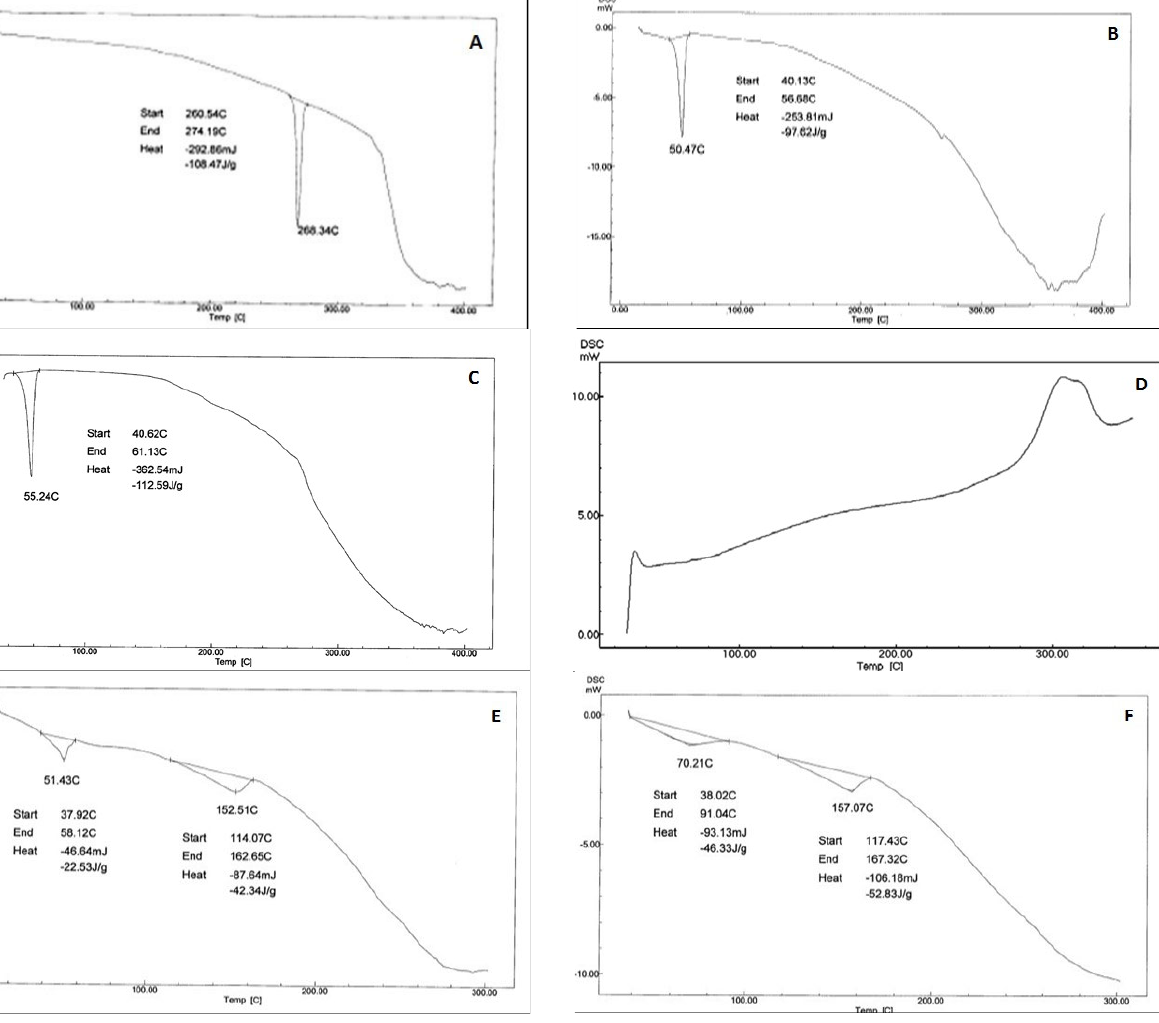
Figure 6. Differential scanning calorimetry of ( A ) Tel, ( B ) PEG 4000, ( C ) Poloxamer 407, ( D ) CCS, ( E ) F14, ( F ) F15.